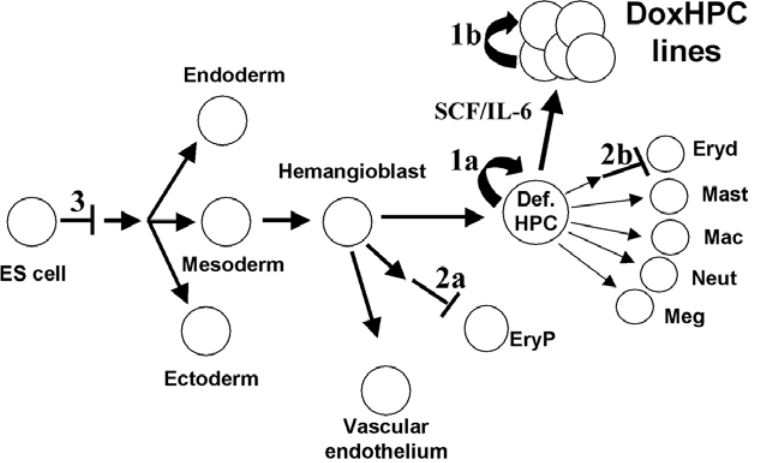
Figure 7. An overview of the effects of Lhx2 expression during ES cell differentiation invitro . 1) Lhx2 expression and simultaneous activation of the c-kit receptor tyrosine kinase and gp130 signal transducer via IL-6 directly induce self-renewal of a distinct multipotential definitive hematopoietic progenitor cell (Def. HPC) present in the EB (1a) leading to the generation of HSC-like cell lines (DoxHPC lines) strictly dependent on Lhx2 expression and SCF/IL-6 for continuous self-renewal in vitro (1b). 2) Lhx2 expression inhibits proliferation of committed primitive erythroid (EryP) precursor cells (2a) and definitive erythroid (EryD) precursor cells (2b). 3) Lhx2 expression interferes with the initial step in ES cell differentiation whereas it does not interfere with the gastrulation process. Mast, mast cells. Mac, macrophages. Neut, neutrophilic granulocyte. Meg, megakaryocytes.